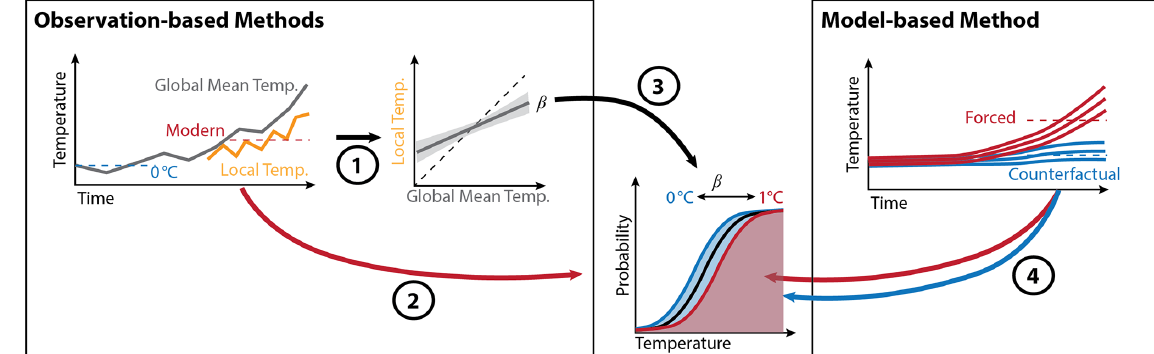
Figure 1. Diagram of this study’s multi-method approach to quantifying local climate attribution estimates. The two observation-based methods begin by (1) relating the local temperature (orange) to GMST (gray) to obtain β , which is the change in local mean temperature with a change in GMST. This includes an error estimate from the linear regression. (2) Observational data are used to characterize a climatological (1985–2015) distribution of temperatures (black curve). (3) Then, the median-scaling method uses β to shift the climatological distribution backward to a preindustrial counterfactual climate (blue curve and shading) and either backward or (typically) forward to a forced distribution of temperatures contemporary with the events being attributed (red curve and shading). Shifts based on GMST are assumed to be completely driven by historical, human-emitted greenhouse gases. The quantile-scaling method uses the same procedure, but models separate β values across 30 specified distribution quantiles. The model-based method uses climate model simulations to characterize the local temperature under natural forcing (blue lines) or in a climate forced by human-emitted greenhouse gases (red lines). (4) The forced and counterfactual distributions of temperatures used to quantify attribution estimates are then inferred directly from the three